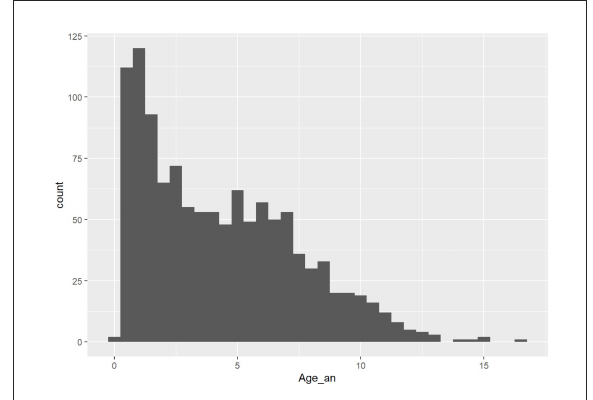
FIGURE1 Age dispersion among the population ( x , age in years; y , number of